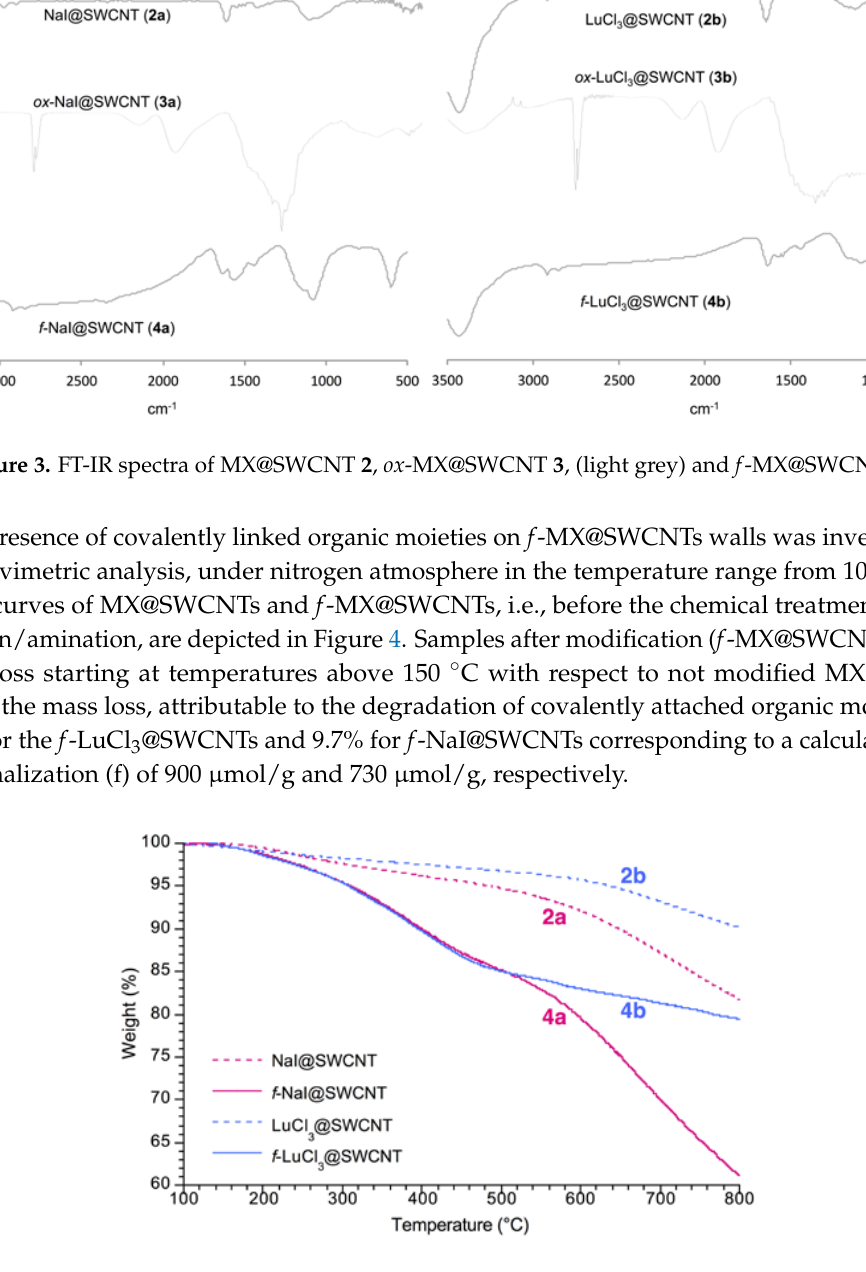
Figure 4 Figure 4. TGA curves of 2 (MX@SWCNTs) and 4 ( f -MX@SWCNTs) under flowing